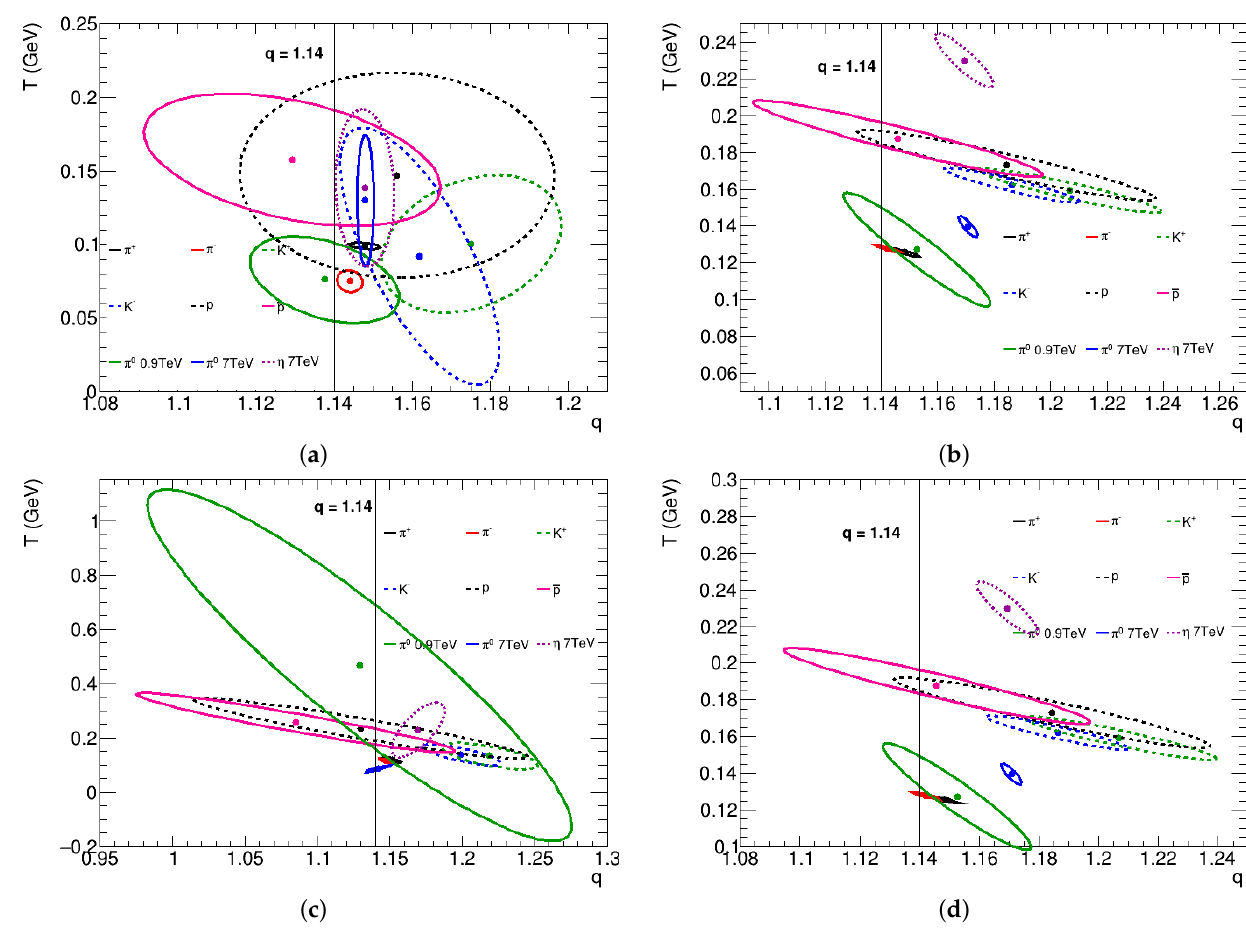
Figure 3. Joint confidence region on the T – q plane in the parameter space, with significance, α = 5%. The regions are obtained by using ( a ) Equation (1), ( b ) Equation (2), and ( c , d ) Equation (3), with ( c ) √ s = 7 TeV are the parameter a o left free to adjust and ( d ) fixed to the value a o = 1. The results for √ s = 0.9 TeV are indicated by the solid circles for the indicated by the asterisks and the results for centers of the